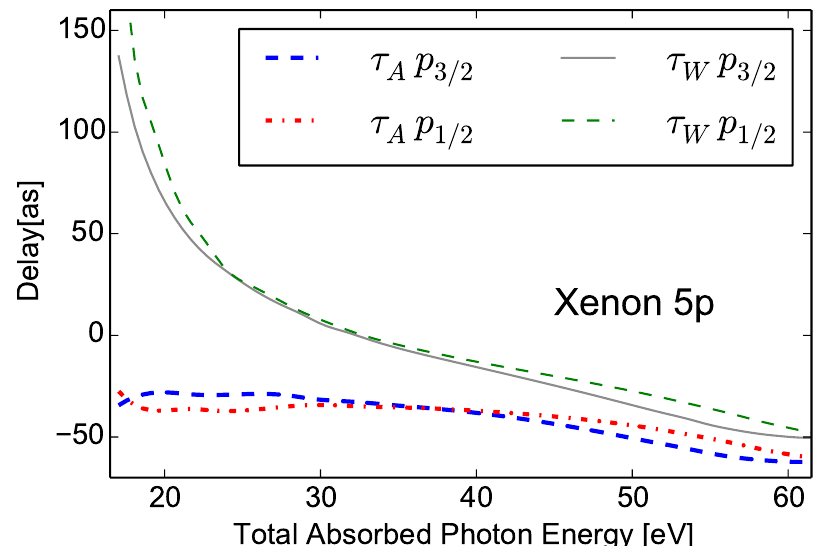
Figure 4. The atomic delay calculated in length gauge for ionization from Xe 5 p j , for electrons emitted along the polarization axis. The thick dashed blue line shows the atomic delay for electrons ionized from 5 p 3/2 , and the dotted–dashed red line shows the atomic delay for electrons ionized from 5 p 1/2 . The thin dashed green and solid grey lines show the Wigner delay for electrons ionized from 5 p 1/2 and 5 p 3/2 respectively. Dirac–Fock orbital energies have been replaced with experimental ionization energies. For 5 p 3/2 , the binding energy is 12.13 eV, and for 5 p 1/2 it is 13.44 eV [94]. Dirac–Fock orbital energies are used for the deeper lying